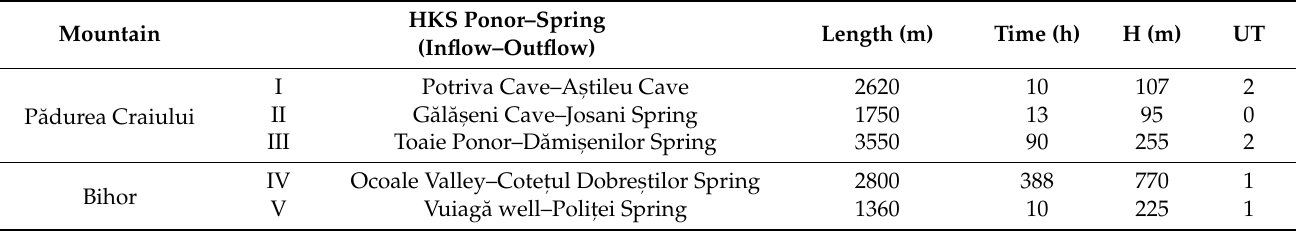
Table 1. Description of the five hydrokarst systems addressed within the present study (information extracted from Or ă s eanu and Iurkiewicz, 2010 [3]). In each case, the length of the underground course , of water is provided, alongside the time needed for the water to flow underground from ponors to springs, the difference in altitude between the two endpoints of the HKS (H) and the number of the underground tributaries that feed the main course (UT). The size of the underground tributaries has not been